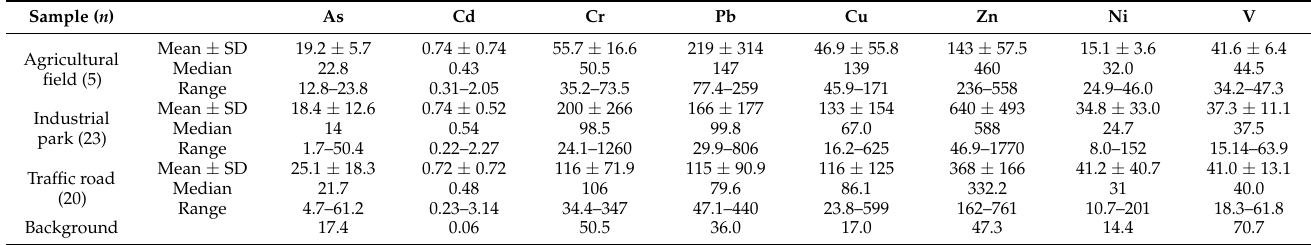
Table 1. Trace metal concentrations (mg/kg) in road dust from agricultural fields, industrial parks, and traffic intersections. The local background values were trace metal concentrations in soil obtained from a previous survey